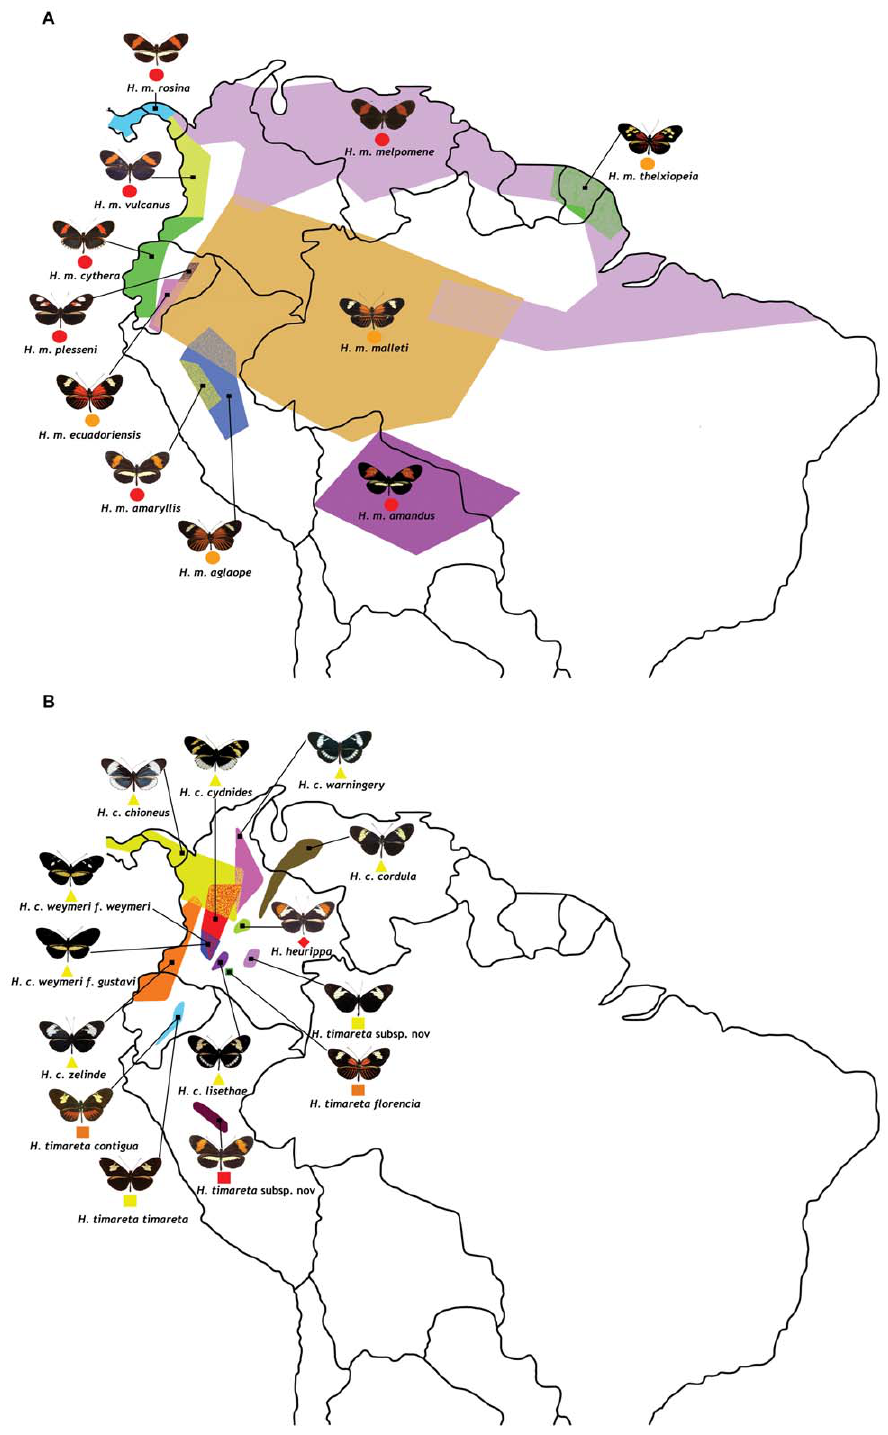
Figure 1. Geographic distribution and phenotype radiation of the species and races used in this study. (a) H. melpomene (circles) and (b) H. cydno (triangles), H. timareta (squares) and H. heurippa (diamonds). Taxa with a rayed phenotype are coloured orange, red-banded phenotypes (red band in the forewing) are red and, those taxa lacking a dorsal red wing phenotype are yellow. The distributions of sampled taxa are estimated from locality data compiled by Neil Rosser. doi:10.1371/journal.pgen.1002752.g001 and is typically considered a red-banded pattern. However, here this phenotype shows an independent origin as compared to other all individuals from this race form a distinct monophyletic group red-banded patterns, consistent with its distinct white and red on the HmB453k genealogy (Figure 4). This perhaps indicates that band phenotype. In addition, six haplotypes from the rayed race